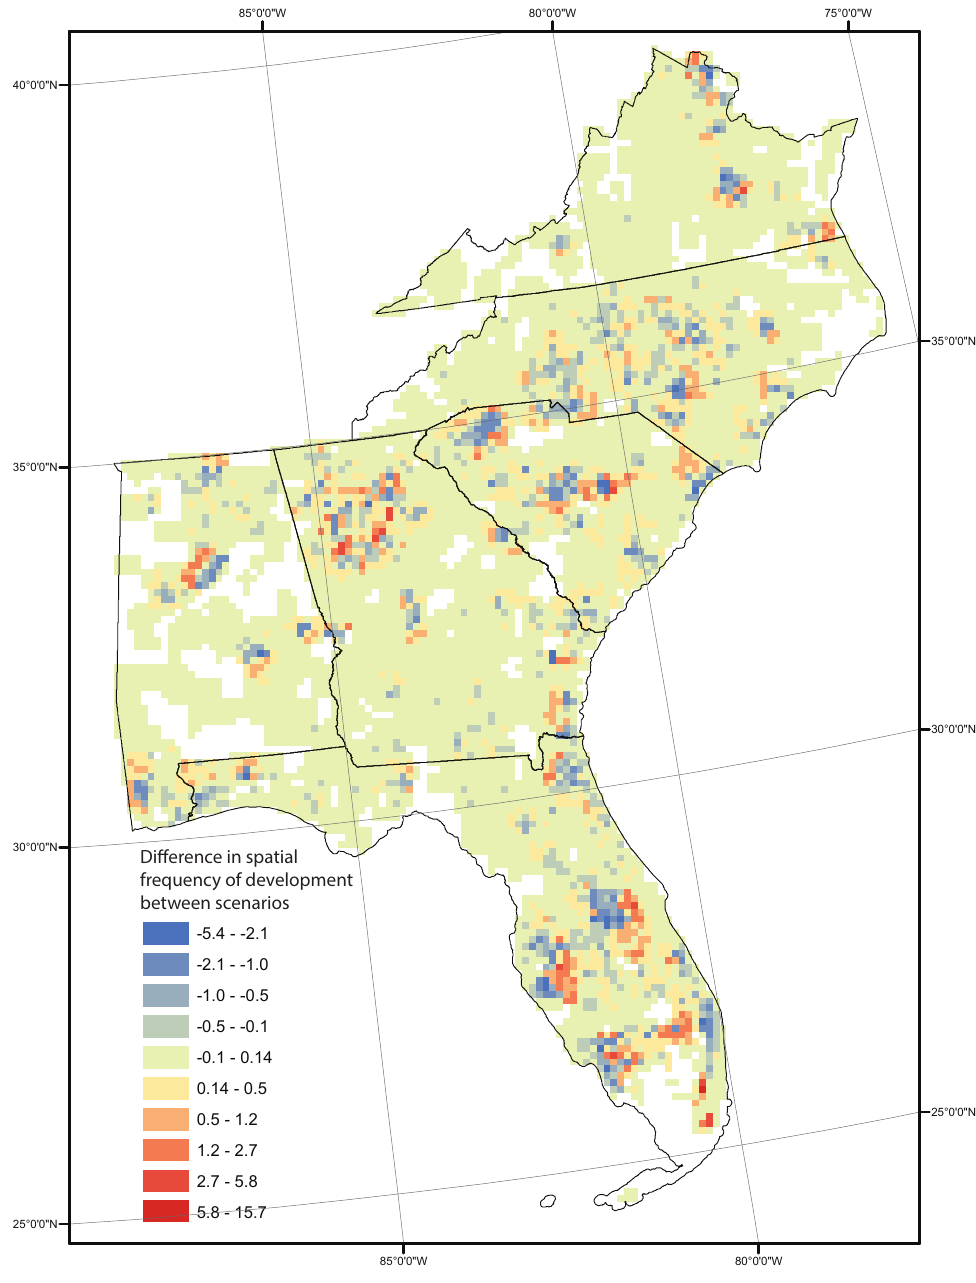
Figure 6. Difference in average frequency of urban development between Status Quo (SQ) and Infill scenarios ( n = 50 simulations) summarized for 100 km 2 cells across the South Atlantic States. We use SQ frequency as the reference value. Positive values (yellow to red) indicate greater frequency of development under the SQ scenario and negative values (yellow to blue) indicate greater frequency of development in the Infill